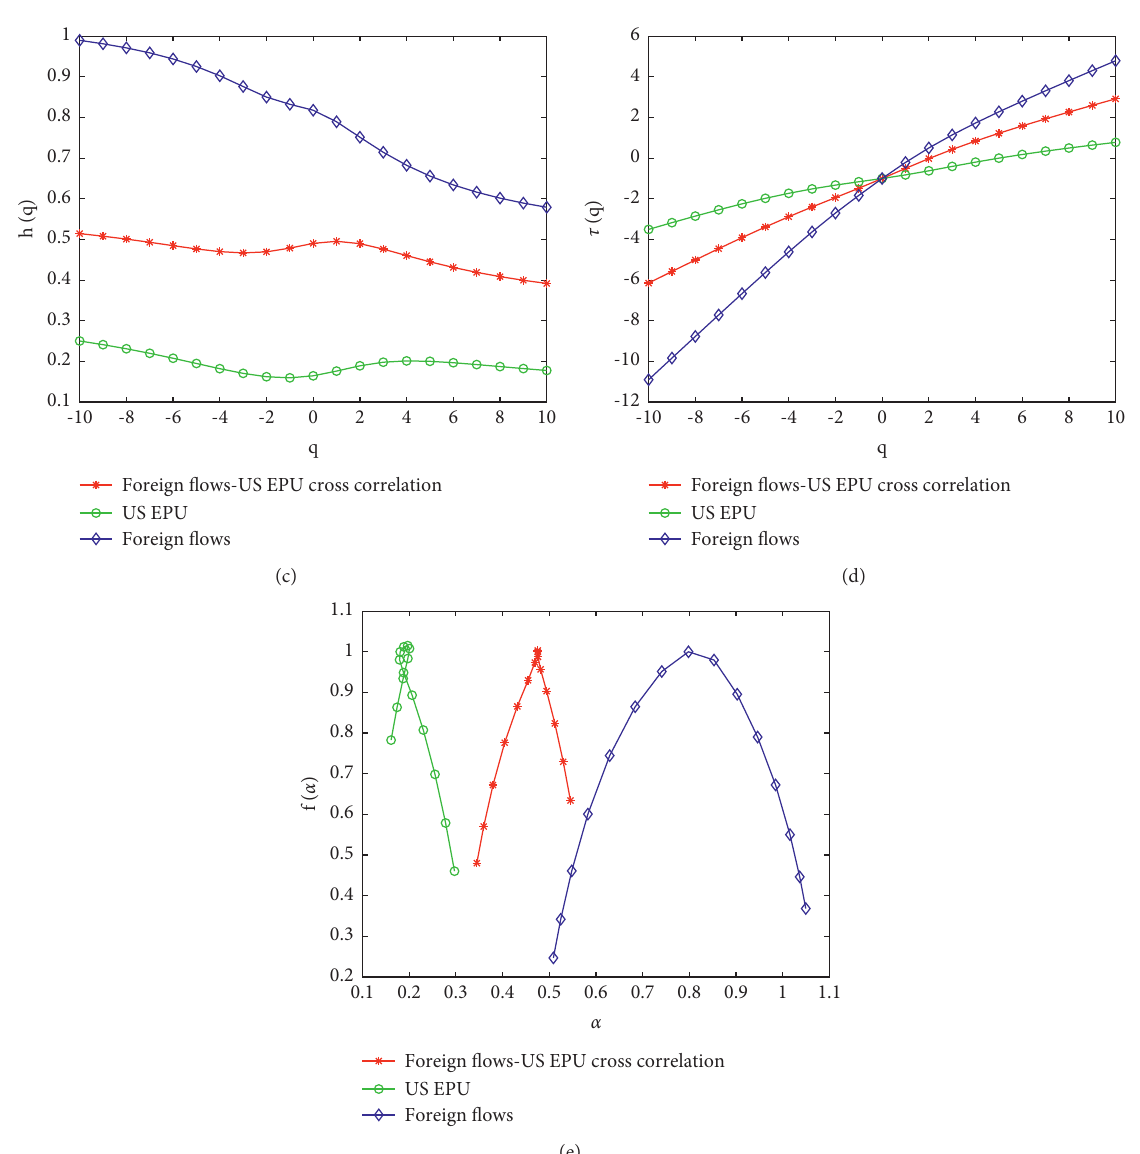
Figure 10: Cross-correlation analysis and MF-DCCA analysis between SGT and US EPU index. (a) Cross-correlation statistics Q (b) Log-log plots of F q ( s ) versus s . (c) Generalized Hurst exponent of H ( q ) versus q . (d) Renyi exponent of τ ( q ) versus q . (e) Multifractal spectrum f ( α ) versus α